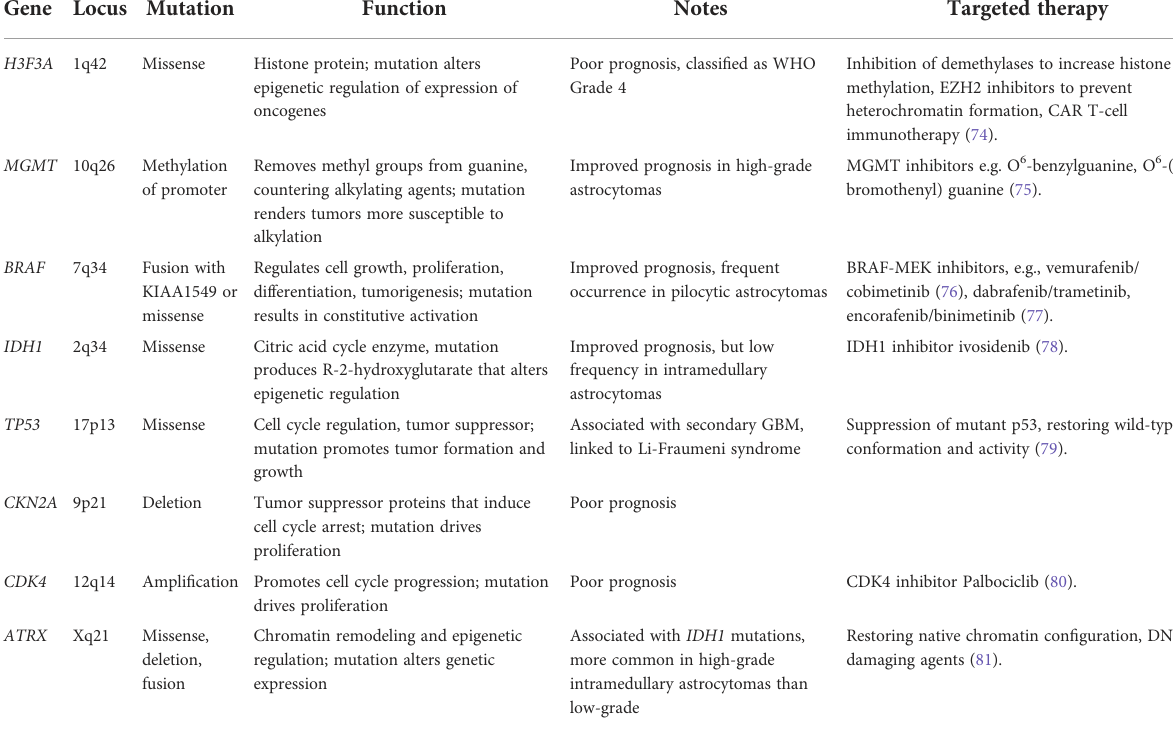
TABLE 1 Genetic mutations frequently associated with intramedullary astrocytomas. Gene Locus